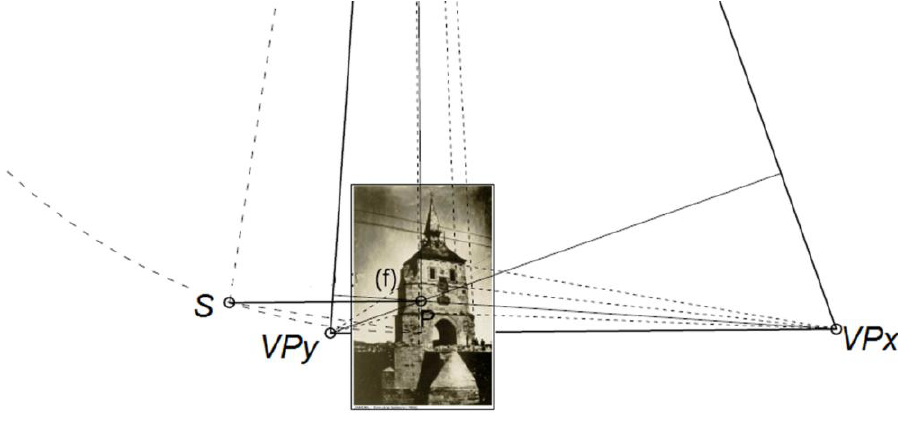
Figure 10. Perspective pyramid computed for the single image-based modeling approach.